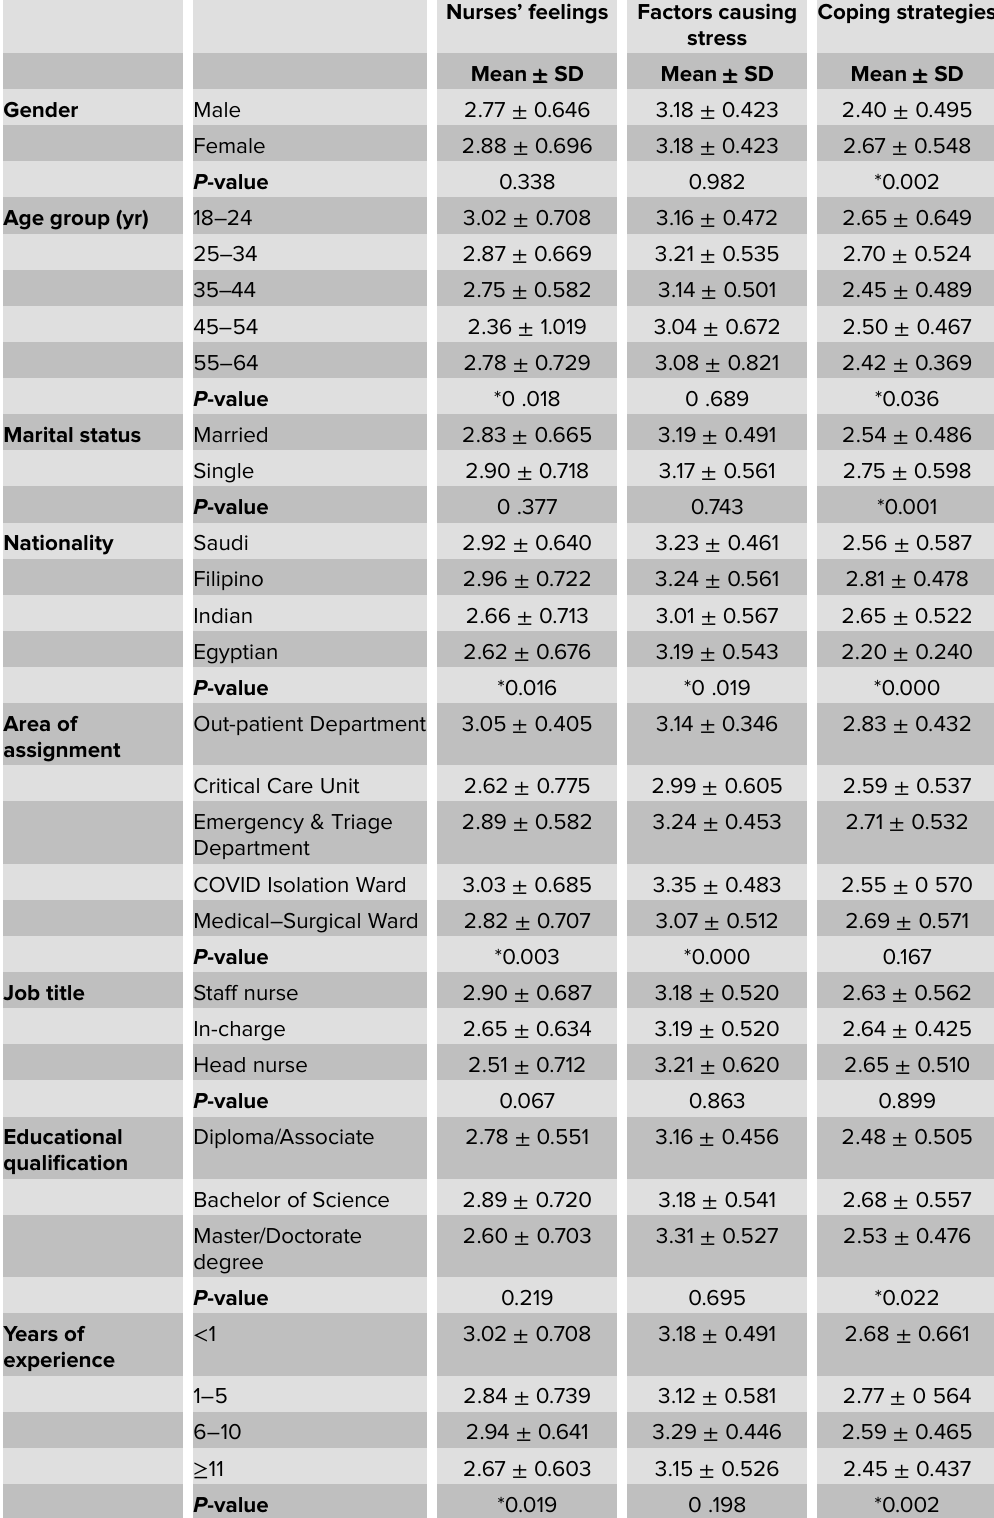
TABLE 4: Comparison of staff feeling, factors causing stress, and coping strategies when grouped by demographic